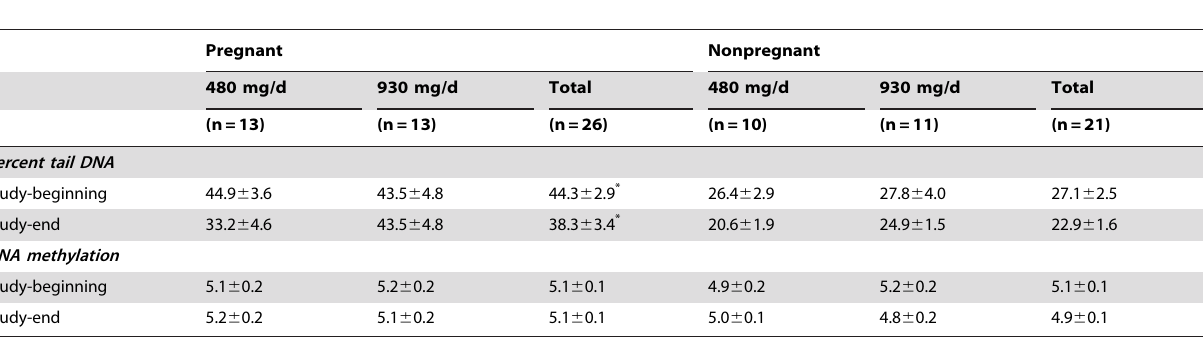
Table 6. Leukocyte DNA damage and global DNA methylation in third trimester pregnant women and nonpregnant women consuming 480 or 930 mg choline/d at the beginning and end of the controlled feeding